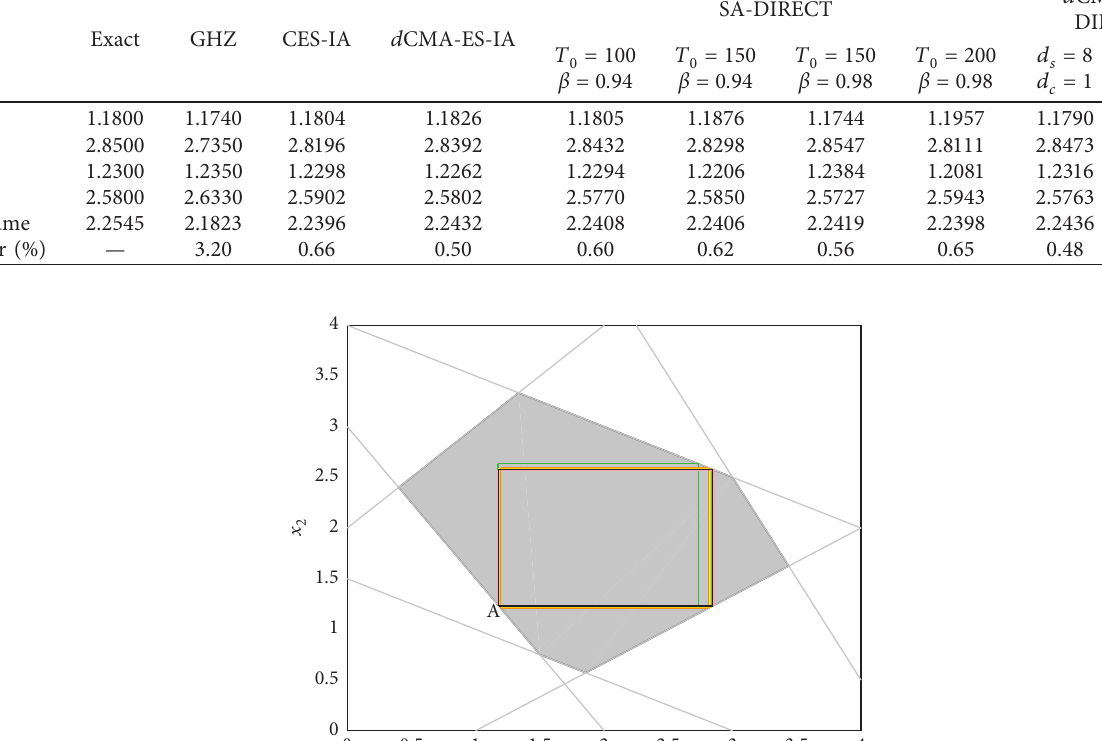
� 100and β � 0 . 94 (blue), SA-DIRECT with T 0 � 200and β � 0 . 98 (orange), d CMA-ES-DIRECT with 0 � 8and d � 3 (black). s c